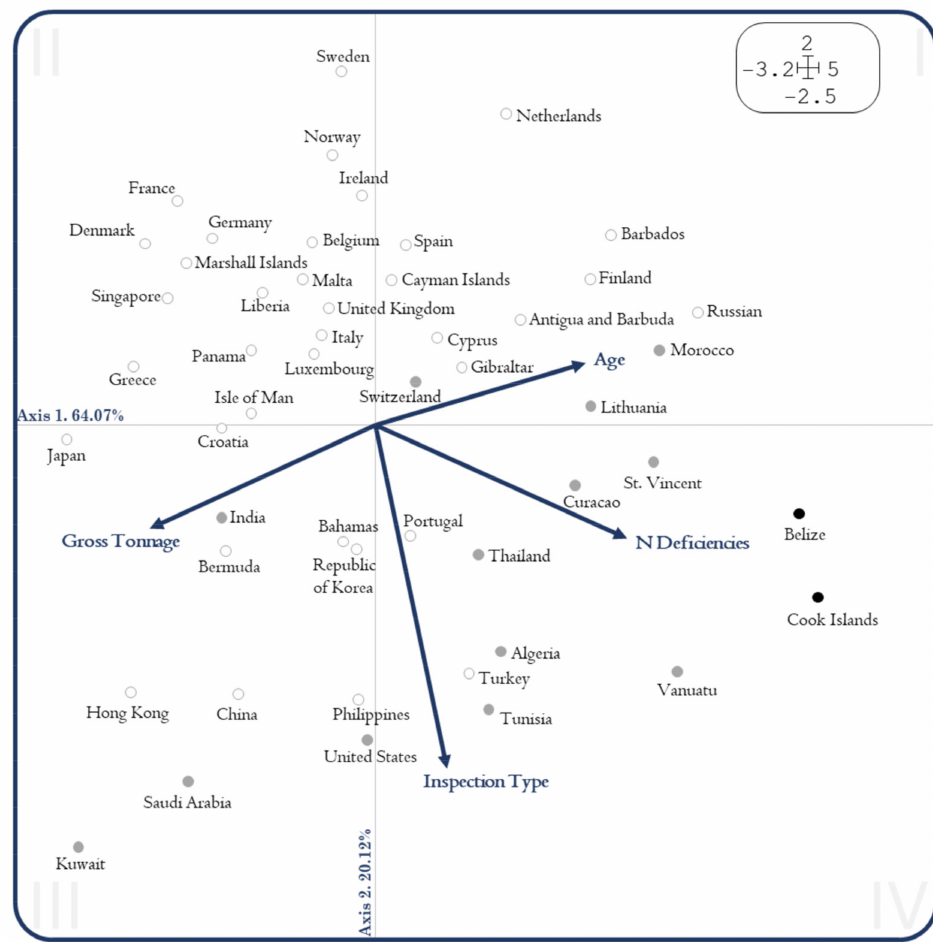
Figure 4. Representation of the 51 countries and four variables on the compromise matrix subspace. The different countries display high variance and are distributed all over the plane, which facilitates the visualisation of differences according to the ship country